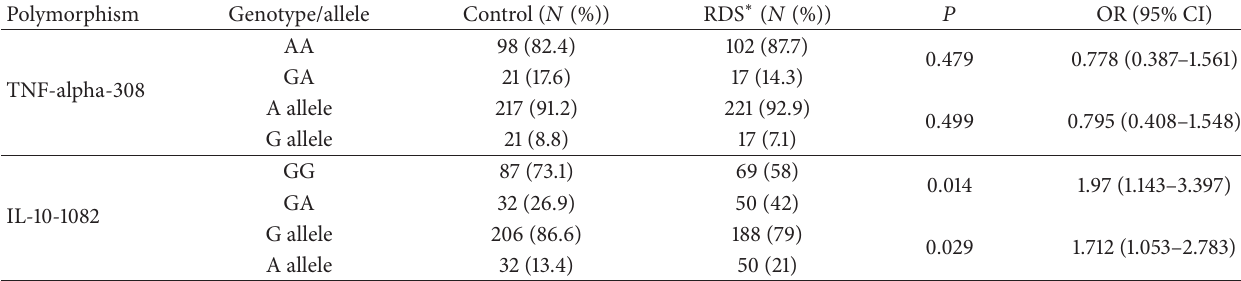
Table 4: Frequency of genotype or allele of TNF- 𝛼 -308 and IL-10-1082 polymorphism in different groups of pediatrics.